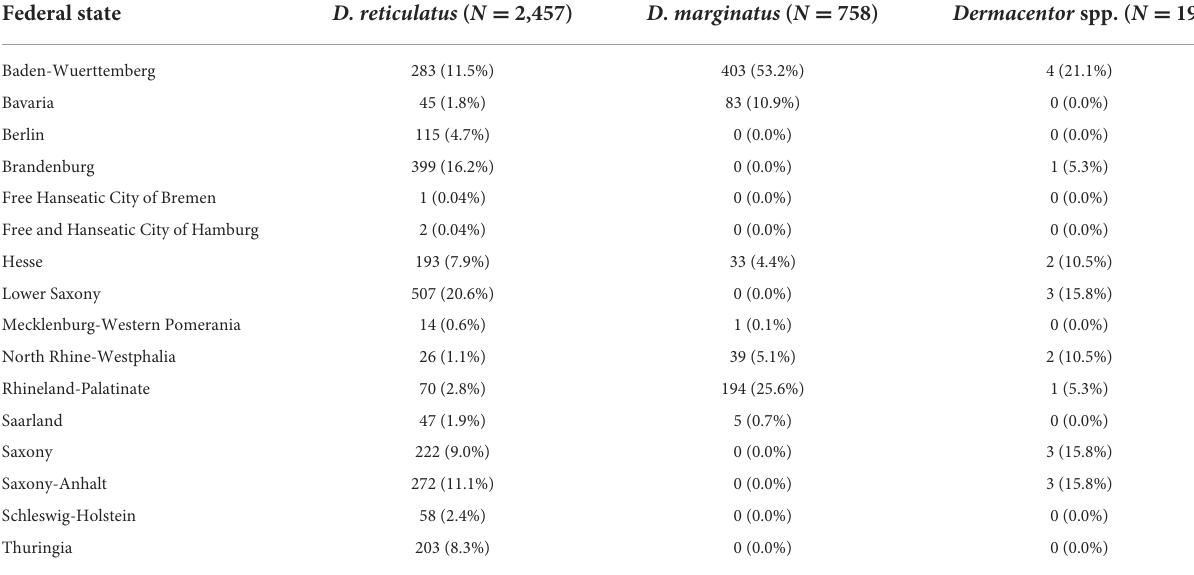
TABLE 1 Distribution of Dermacentor ticks with unambiguous origin among the federal states of Germany, received from March 2020 to May 2021. Federal